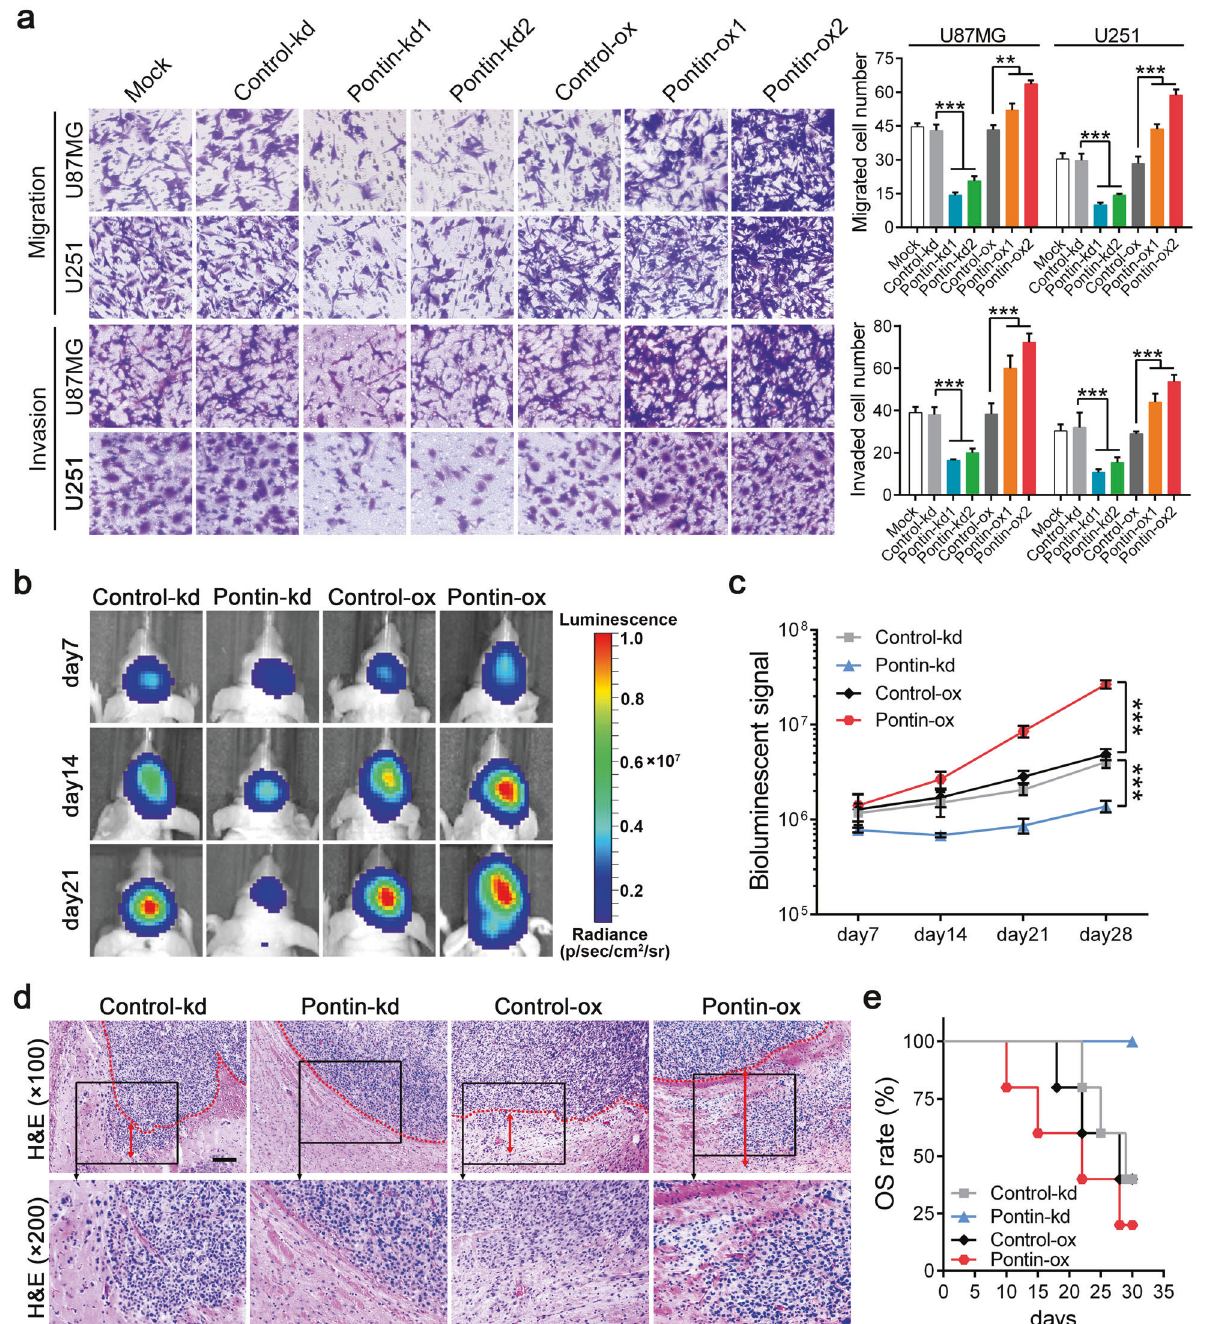
Fig. 3 Pontin increases GBM cell migration, invasion and tumorigenic potential. a Representative images of transwell migration and invasion (left) and the comparison results (right). Data are expressed as means ± SDs, n = 3. ** P < 0.01, *** P < 0.001 by one-way ANOVA (Dunnett ’ s post test). b Representative bioluminescent images revealing the xenografts in mice brain formed by indicated U87MG cells. c Quanti fi cation of the bioluminescence data monitored at Day 7, 14, 21 and 28 after transplantation. Data are expressed as means ± SDs, n = 5. *** P < 0.001 by one-way ANOVA (Dunnett ’ s post test). d Representative H&E staining images of the indicated xenografts. Red dotted lines labeled the junctions between xenografts and surrounding non-tumoral brain tissues. Invasion distances was indicated by red double- sided arrows. Scale bar, 50 μ m (×100). e Survival curve of the tumour-bearing